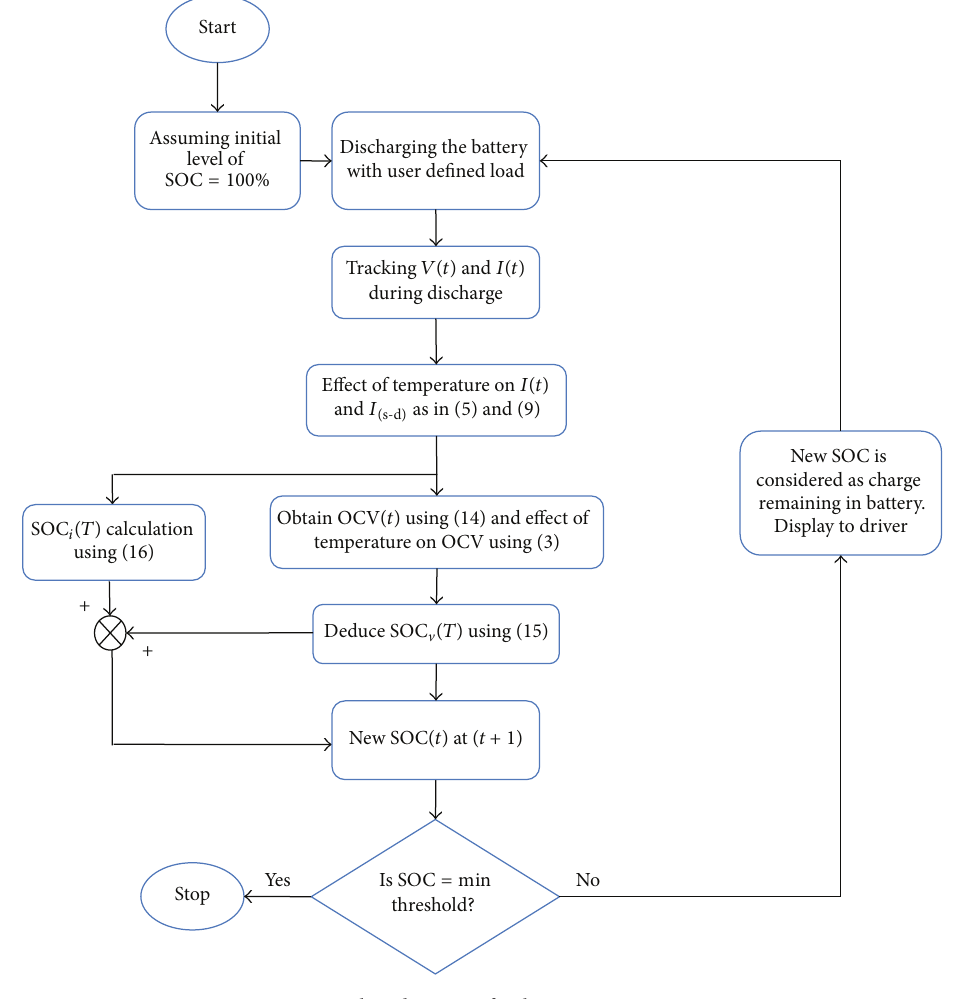
Figure 2: Flow diagram of online SOC estimation.